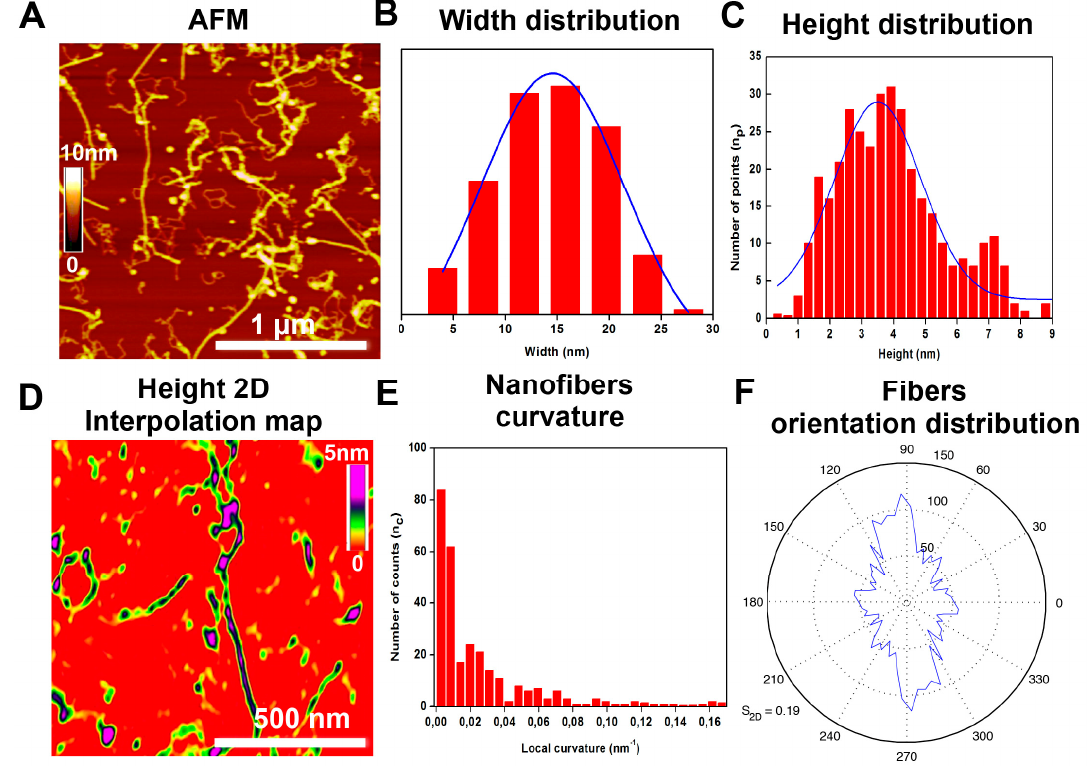
Figure 4. Morphological organizations of assembled peptide nanostructures. ( A ) Atomic force microscopy (AFM) images of the cross-linked LDLK12 that self-organize into elongated and unbranched fibers; ( B ) width fibers distribution and ( C ) height profiles of cross-linked peptide fibers; ( D ) 2D interpolation heights map of the cross-linked LDLK12 showing an average value of 3.65 nm; ( E ) cross-linked nanofibers curvature profile; and ( F ) orientation distribution of the cross-linked LDLK12 fibers along one direction.